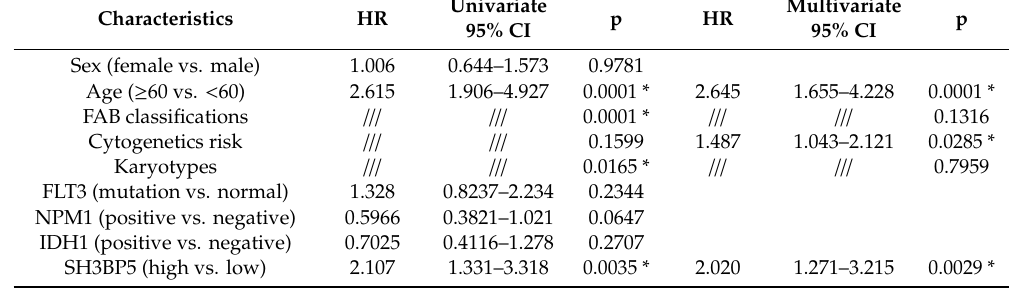
Figure 2. Elevated expression of SH3BP5 inversely correlated with survival of AML patients. ( A ) Overall and ( B ) disease-free survival of AML patients relative to SH3BP5 mRNA was determined by Kaplan–Meier analysis. Patients were divided into two groups based on expression levels of SH3BP5 above or below the 50th percentile. (A - B, data from the TCGA AML database). Table 2. Univariate and multivariate Cox regression analysis of overall survival in AML patients; * represents p values with significant difference.